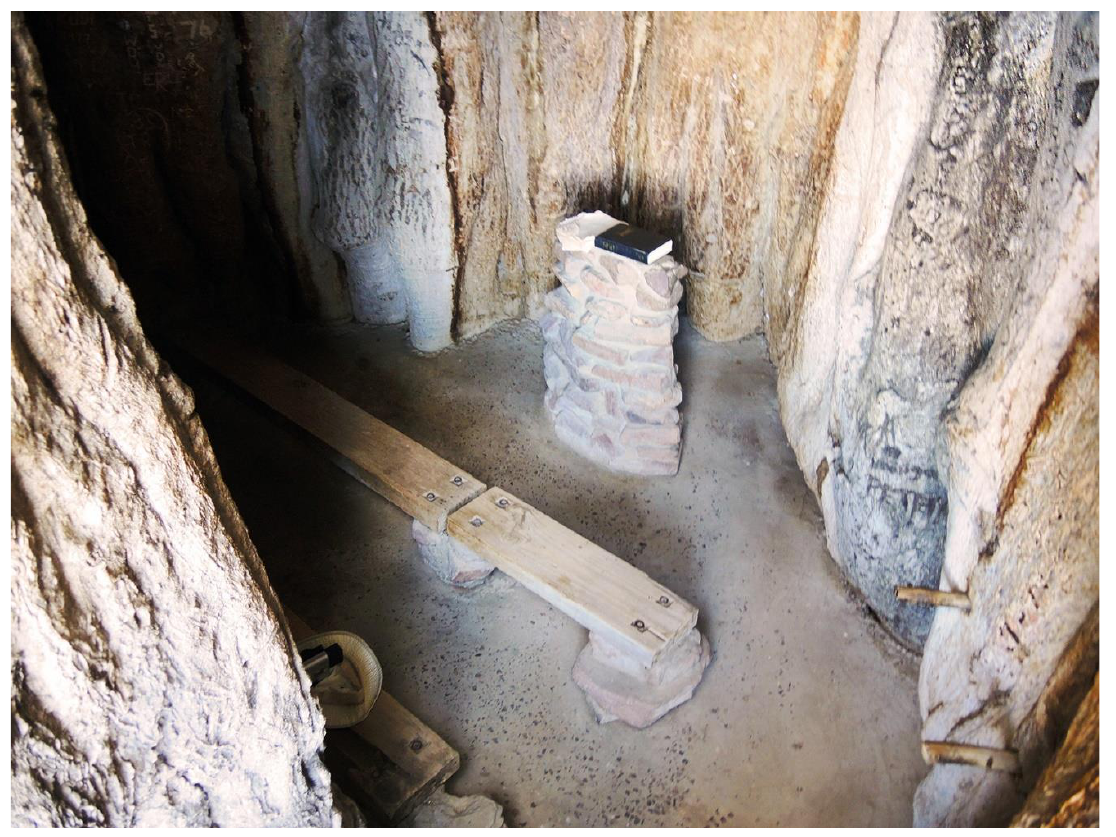
Figure 3. The false cavity of the Ombalantu baobab with the stone pulpit that served as an altar and benches.